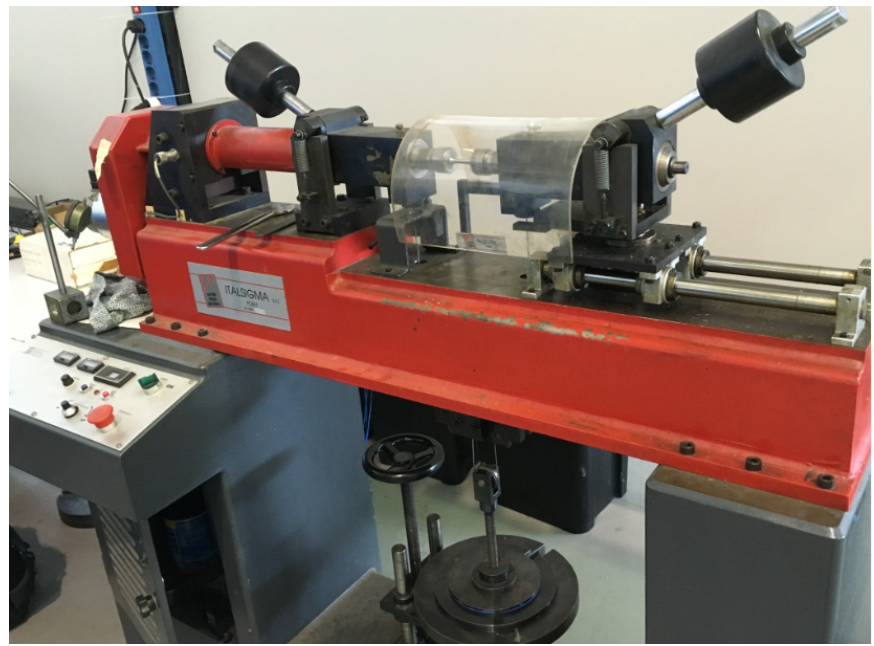
Figure 3. A photo of the testing machine for fatigue tests under rotary bending. The displayed picture was taken during a trial.